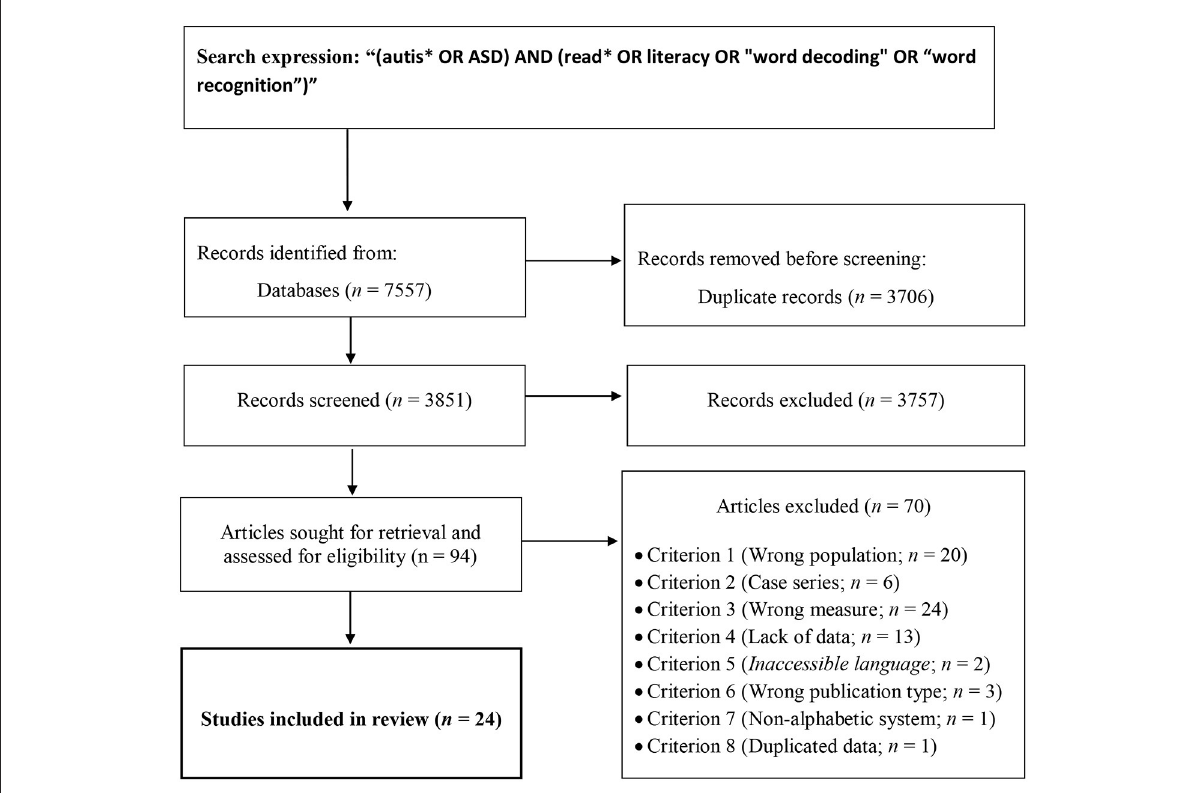
FIGURE1 Flow diagram illustrating the systematic search, results and the selection of the studies included in this systematic review.